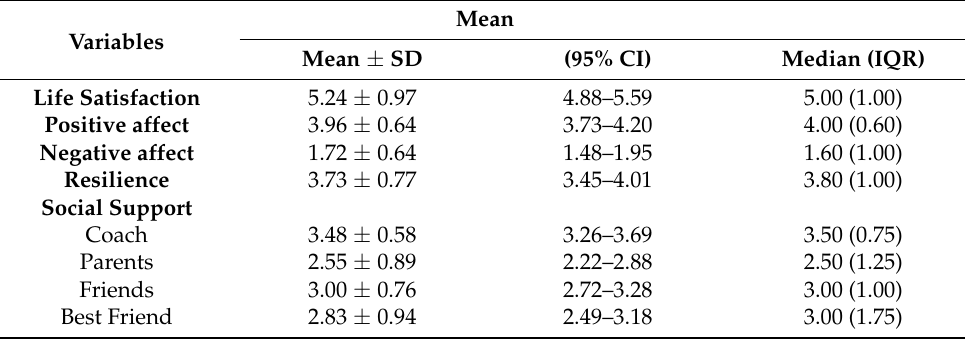
Table 2. Summary of the descriptive statistics for the sample variables ( n = 31).